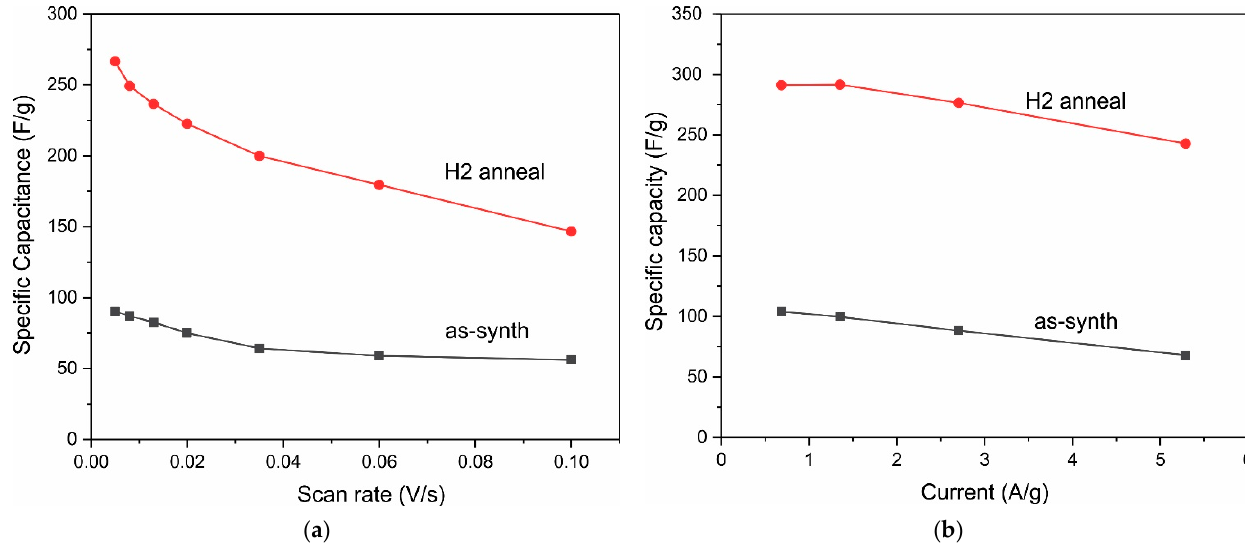
Figure 5. The specific capacitance of the Co 3 O 4 NPs electrode with a loading of 5.2 mg vs. scan rate ( a ) and discharge current ( b ). ( a ) and discharge current ( b